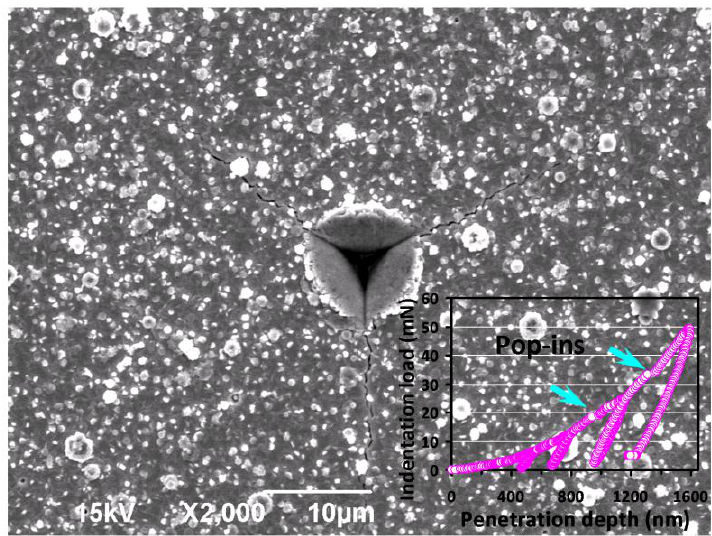
Figure 4. Nanoindented SEM micrograph of Bi 2 Se 3 thin film showing cracks propagate along the corners and pile-up beside the edges of the Berkovich indent. The inset shows the cyclic load-displacement curve at a load of 50 mN. Notice that the multiple “pop-ins” is observable (indicated by the arrows) in loading segments.